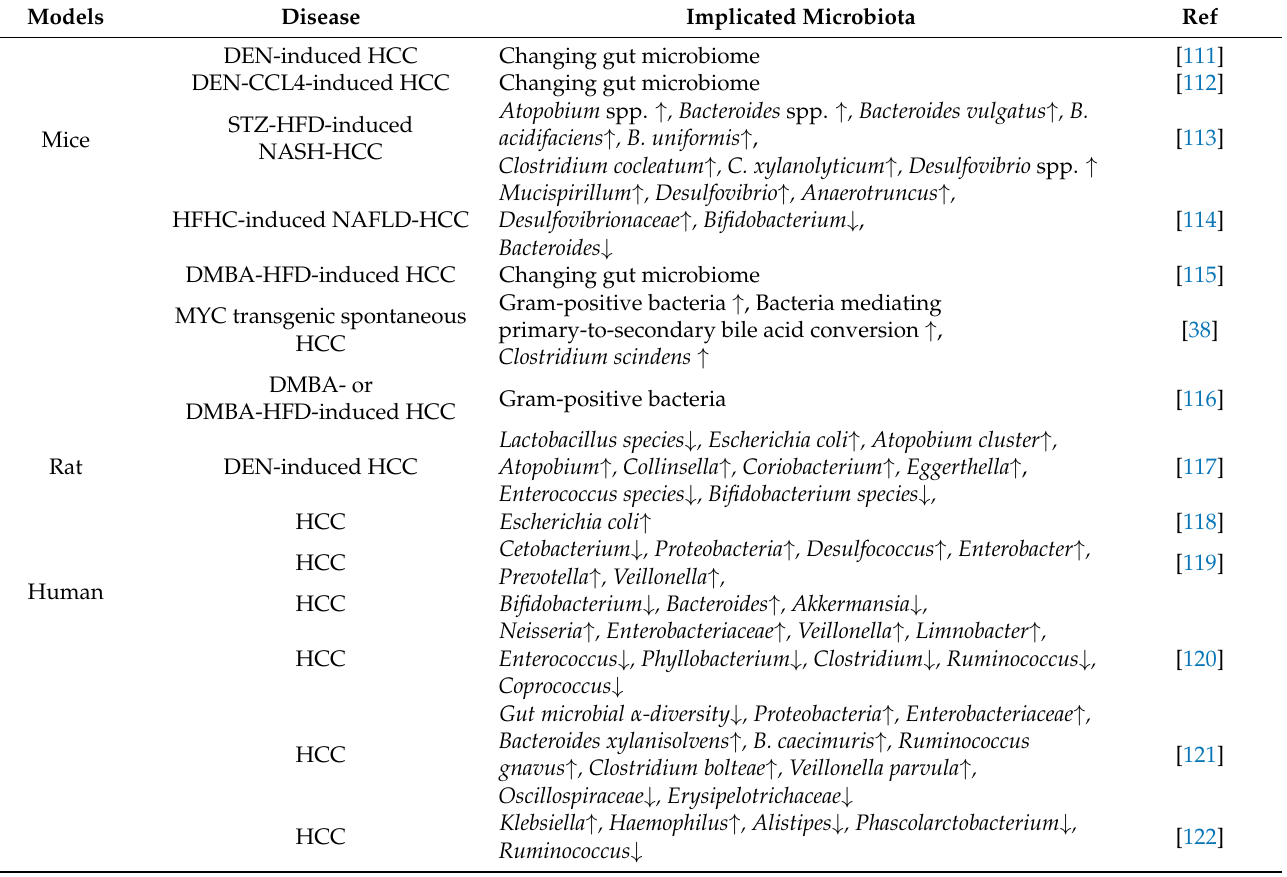
Table 3. HCC-related changes in the microbiota’s regulation in animal, rat, and human models. Predominant microbiota present on various sites and their regulation with